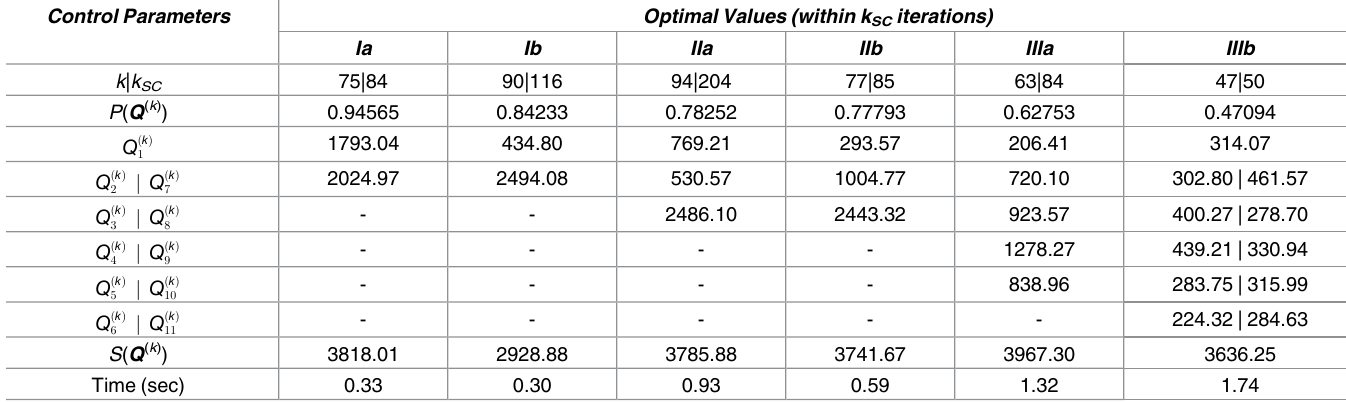
Table 6. Implementing the Stopping Criterion: ALOPEX Optimal Parameter Values. Control